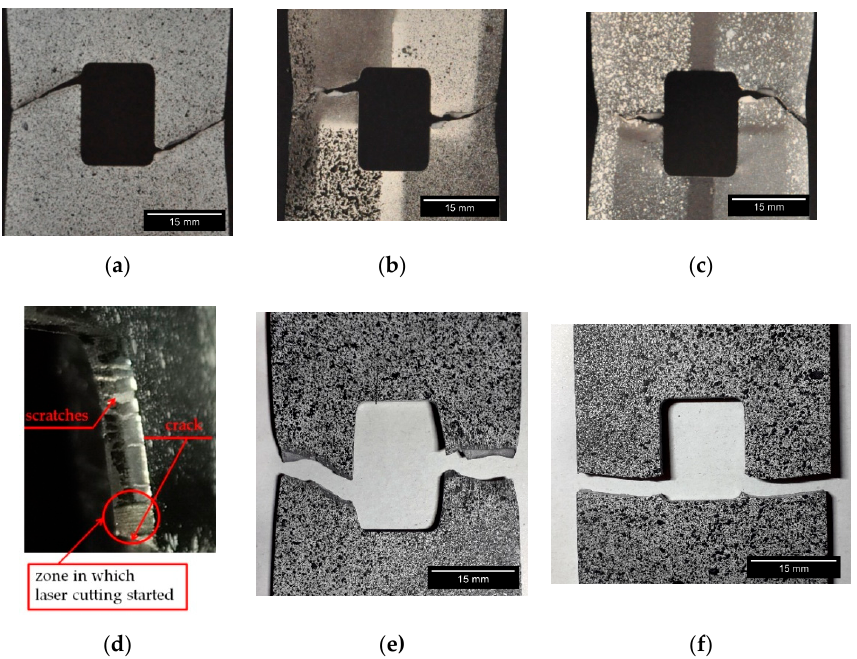
Figure 19. Failed samples made of 41Cr4: ( a ) Sample 11, 41Cr4 + AC, 23 HRC; ( b ) Sample 12, 41Cr4 + AC, 23 HRC; ( c ) Sample 13, 41Cr4 + AC, 23 HRC; ( d ) view on lateral side of the hole of Sample 12 with visible scratches, start point of laser cutting and crack; ( e ) 41Cr4 + QT, 35 HRC; and ( f ) 41Cr4 + Q, 54 HRC. The notched sample subjected only to hardening 41Cr4 + Q revealed brittle behavior without visible plastic strains in the σ – ε curve. The cracks initiated in the points with the highest stress concentrations and no plastic deformation were observed around the hole area (Figure 19f).